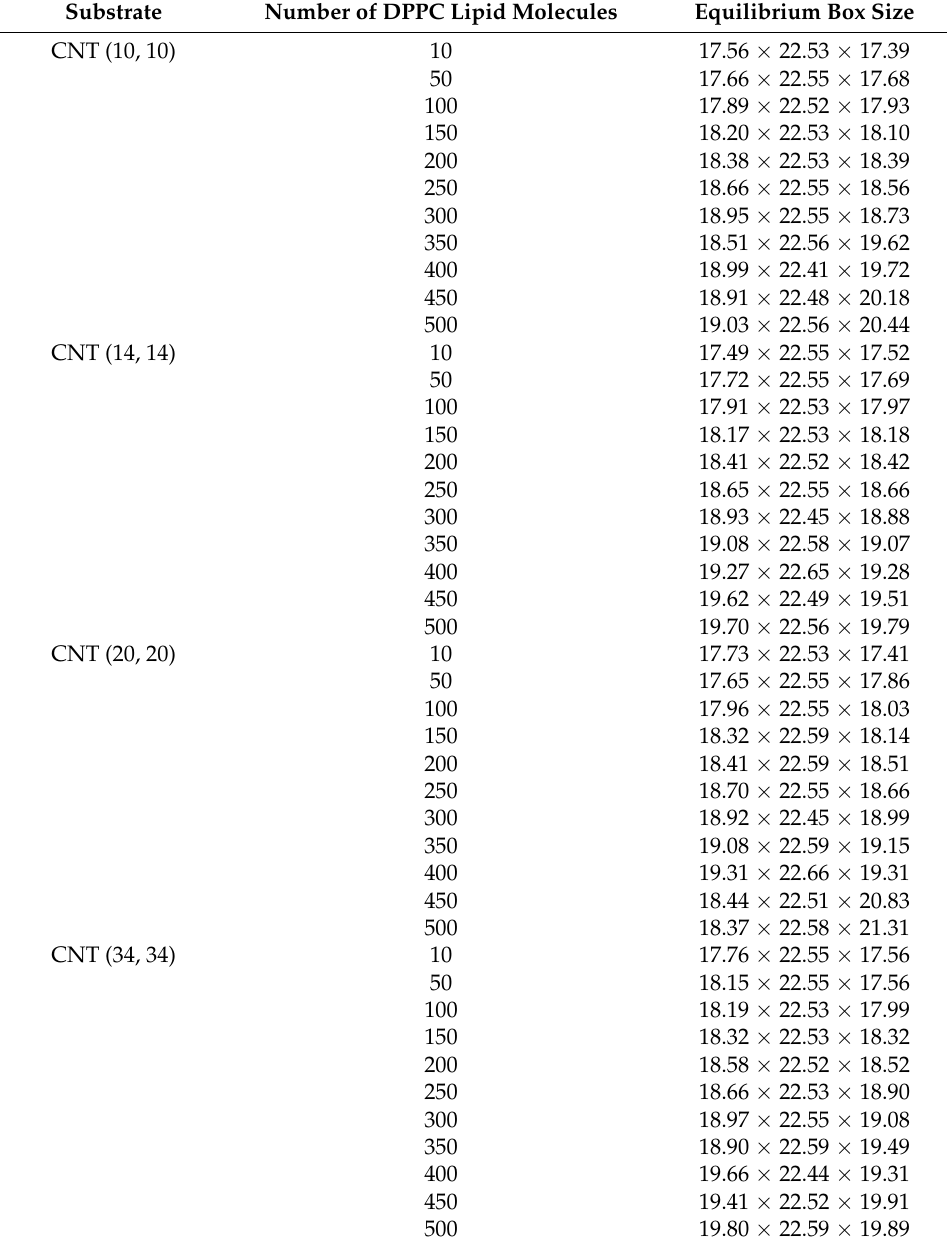
Table 2. Details of the systems simulated in this